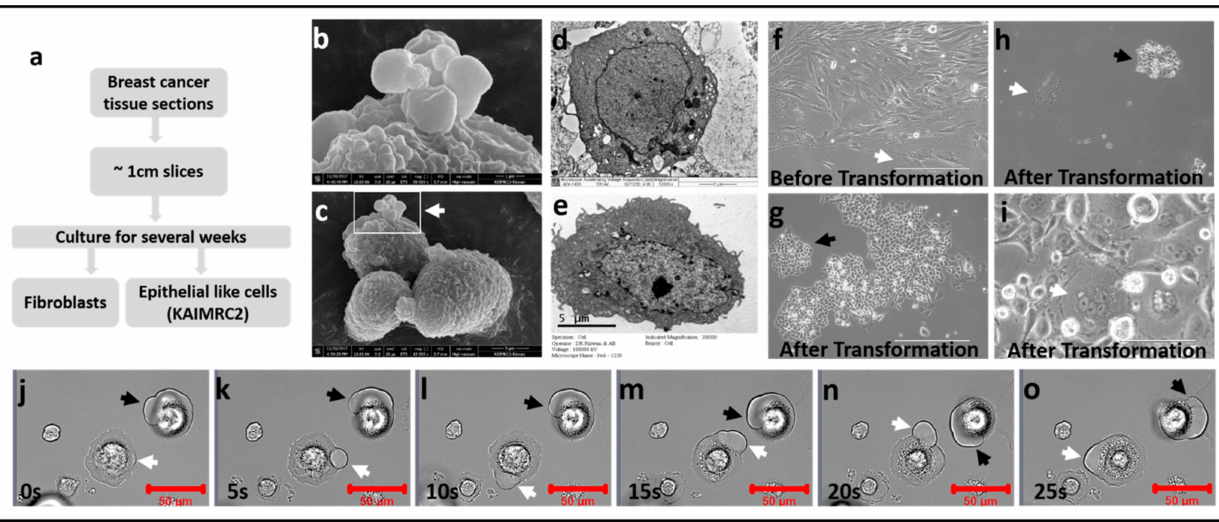
Figure 1. Microscopic characterization of the KAIMRC2 cell line. ( a ) Schematic representation of the workflow of isolation and culture of cancerous cells. Briefly, collected tissue sections were minced into approximately 1 cm pieces, followed by several weeks of growth in normal cell culture media. Large fibroblastlike cells were passaged for almost 15 times. Afterward, smaller sized, cuboidal, and epithelial-like KAIMRC2 cells started to make colonies. ( c ) SEM image of the KAIMRC2 cell line with a large-sized lipid droplet formation on its surface. Scale bar = 5 µ m. ( b ) Enlarged image of lipid droplet on the surface of the cell membrane. Scale bar = 1 µ m. ( d , e ) TEM images of KAIMRC2 cells. Large lipid droplets are apparent inside and outside the cell in the image, d. Scale bar = 2 µ m. ( f ) The transmitted light image of KAIMRC2 cells before the transformation. Elongated and fibroblastlike cells are visible. Scale bar = 400 µ m. ( g , h ) Cuboidal cells after transformation. Scale bar = 400 µ m. ( i ) Cell size shrinks to 4–5 um, and cells started to make small round colonies (black arrowheads), a typical cancer cell characteristic. Multinucleated giant cells are also visible (white arrowheads), suggesting another subpopulation of cells, probably CSCs. Scale bar = 100 µ m. ( j – o ) Transmitted light time-series images of adhesion of KAIMRC2 cells on a glass surface. White and black arrows show the formation and circular movement of lipid droplets during cells to the glass surface adhesion process. To the best of our knowledge, this is a very novel mechanism of cell adhesion that has not been shown before. A video of this process is available in the Supplementary Materials (Supplementary Video